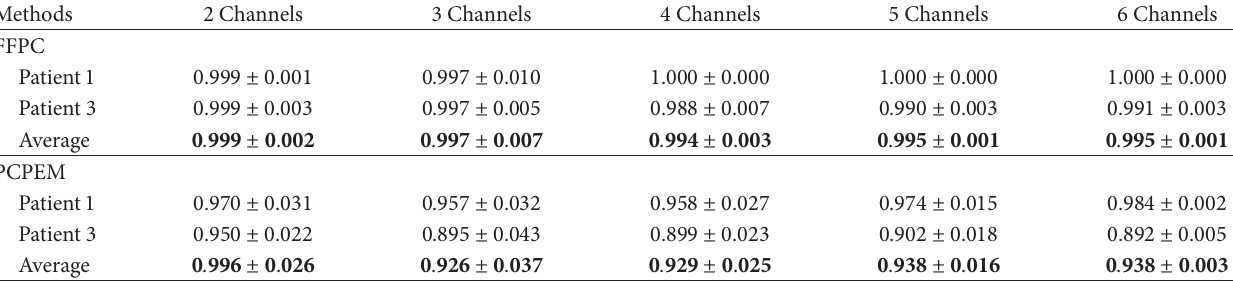
Table 4: The classification accuracy (i.e., the proportion of all signal types correctly detected) using methods of FFPC and PCPEM with window size 𝑙 = 1280 for the epileptic seizure detection problem using EEGs from Freiburg dataset. The channels used for classification are randomly selected from those 6